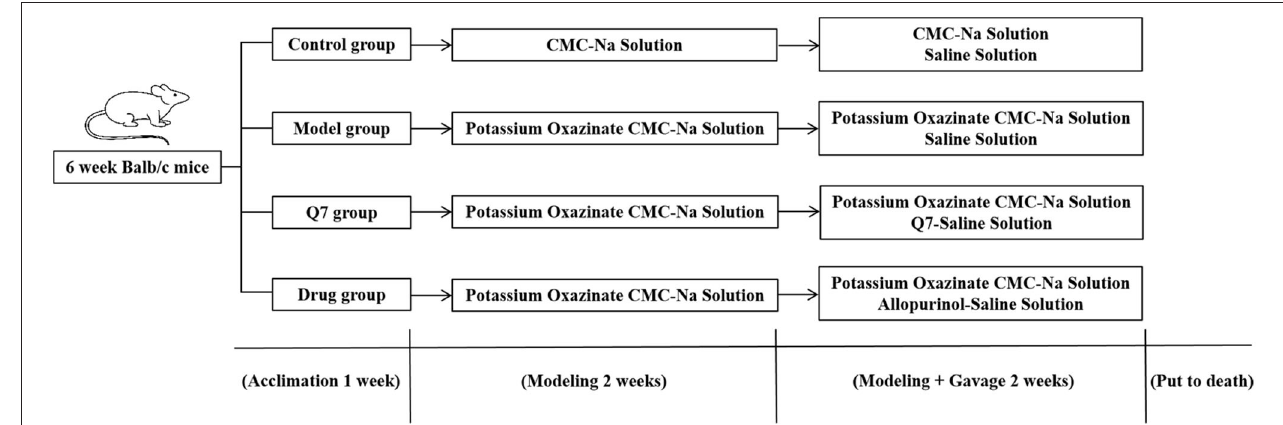
FIGURE 1 | Experimental chart in the treatment of HUA mice.